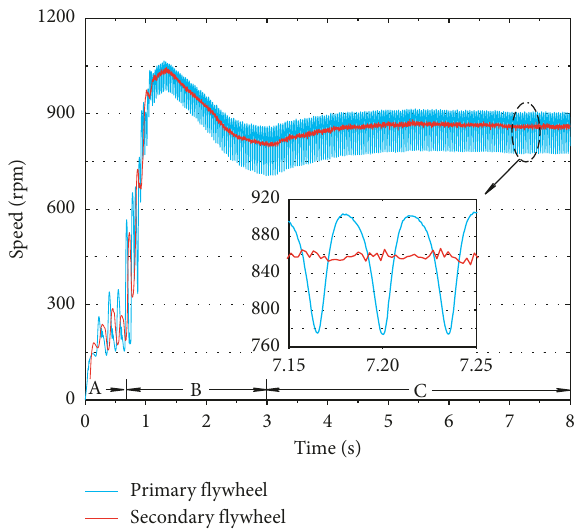
Figure 8: Testing speed fluctuation.